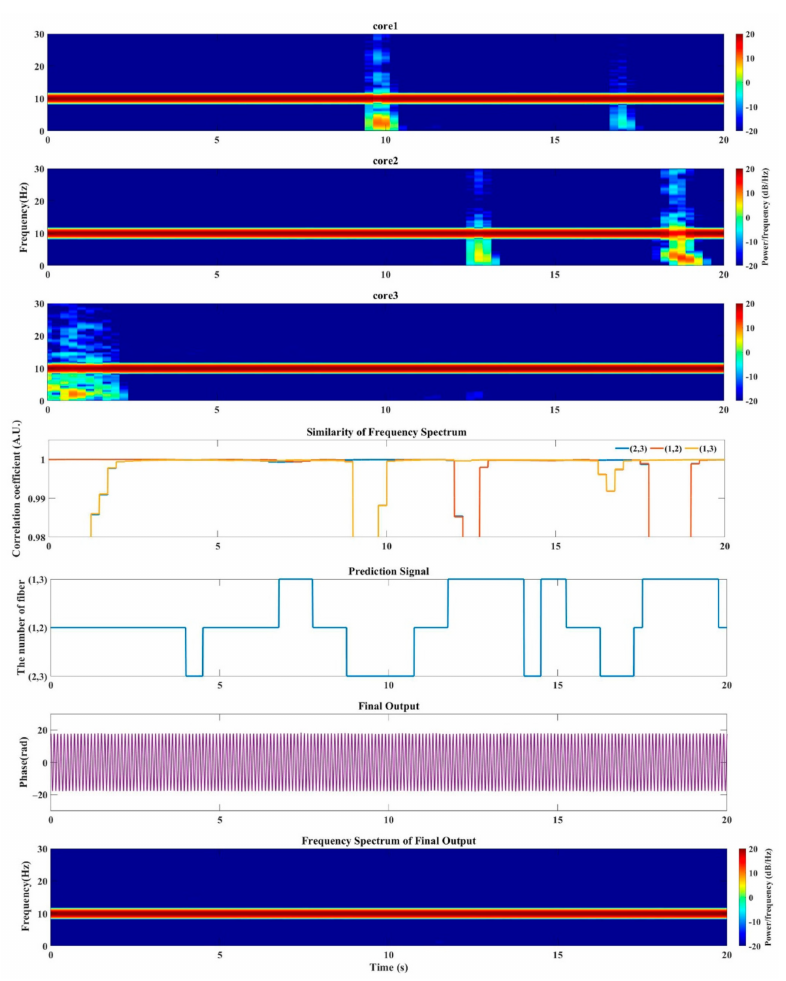
Figure 10. Extracted phase signal from all single beat frequency, as well as prediction signal and final output (selection based on frequency domain).